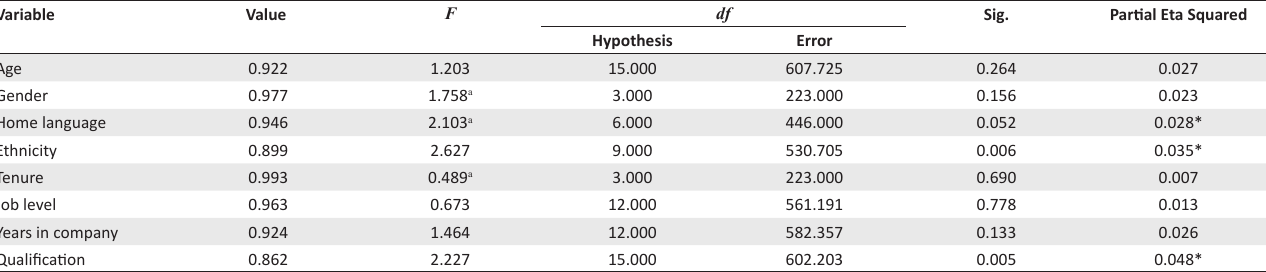
TABLE 6: Manova for work engagement and demographic variable.